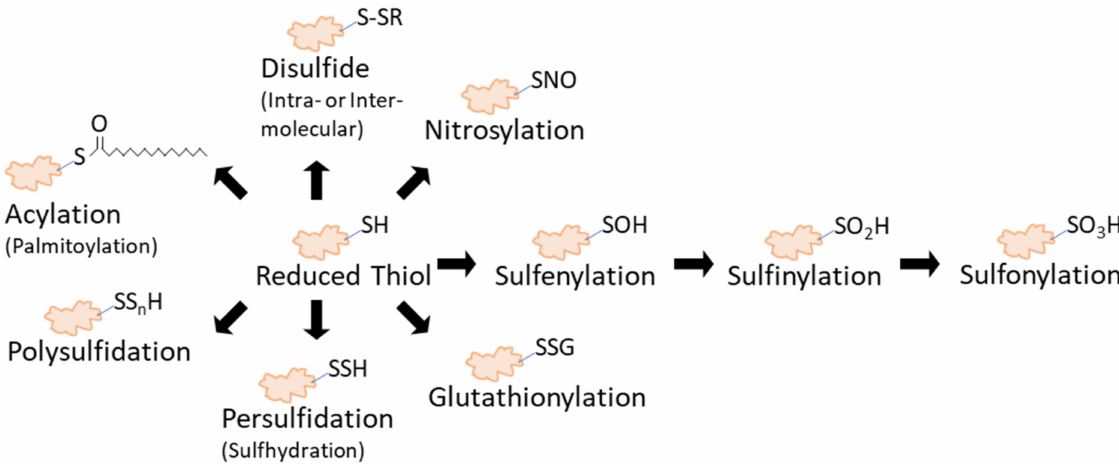
Figure 1. Cysteine thiol modifications. Reduced thiols can be subjected to multiple types of modifications. In this cartoon, disulfide formation includes those that form intramolecularly, or within the same protein, or intermolecularly through exchange with a sulfur group on another protein or molecule. Sulfinylation and sulfonylation occur as subsequent, irreversible oxidative modifications of cysteine thiols that are sulfenylated. Note that persulfidation is also referred to as sulfhydration. Palmitoylation is shown here as a representative modification of acylation, which is the covalent linking of an acyl chain to a cysteine; however, acylation can include other molecules besides 16C palmitate. With the exception of sulfinylation and sulfonylation, all modifications illustrated here are considered